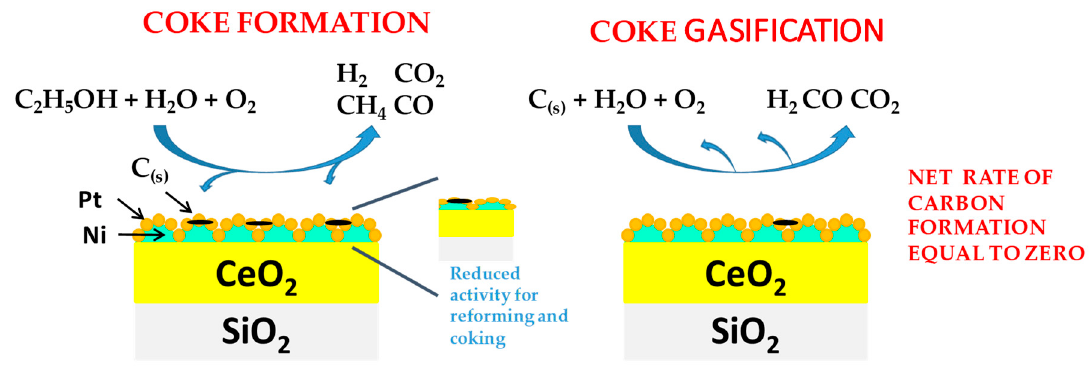
Figure 5. Description of the partial activity loss observed for Pt-Ni/CeO 2 -SiO 2 catalysts during oxidative steam reforming of ethanol (OSRE) at 500 °C, where C 2 H 5 OH/H 2 O/O 2 = 1:4:0.5 [61].